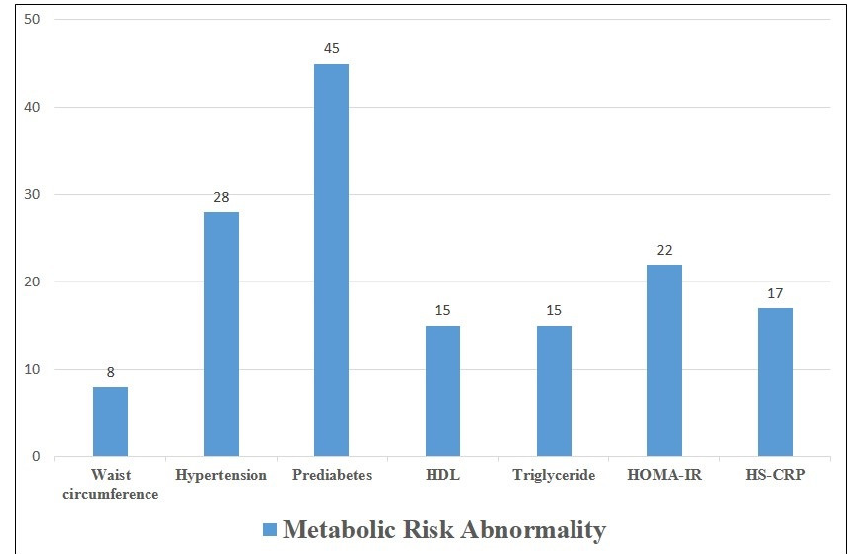
Figure 3. Number of metabolic risk abnormalities in lean MAFLD group.